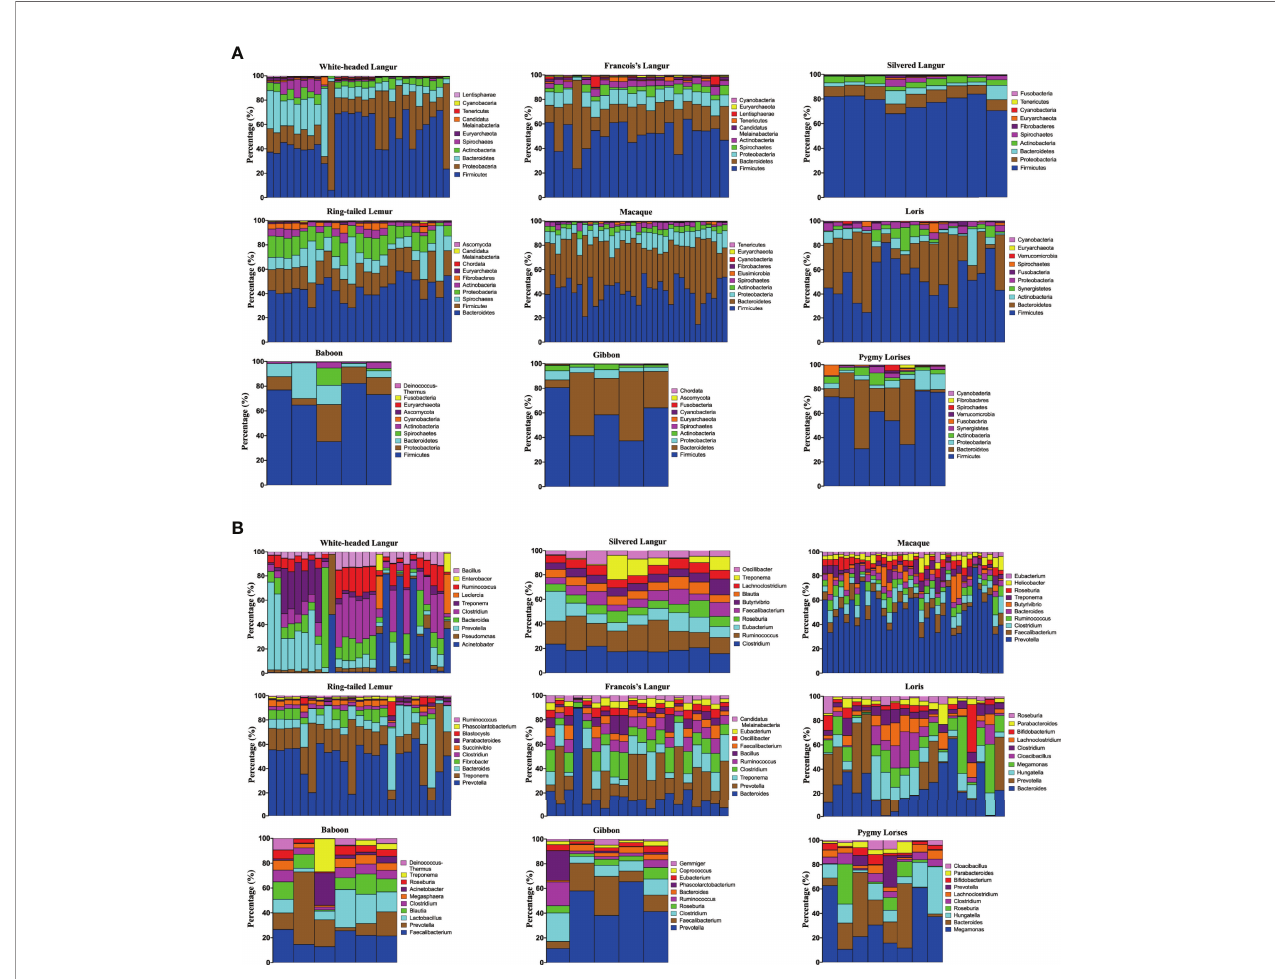
FIGURE 2 | Taxonomy annotation. (A) Taxonomy annotation in phylum. (B) Taxonomy annotation in